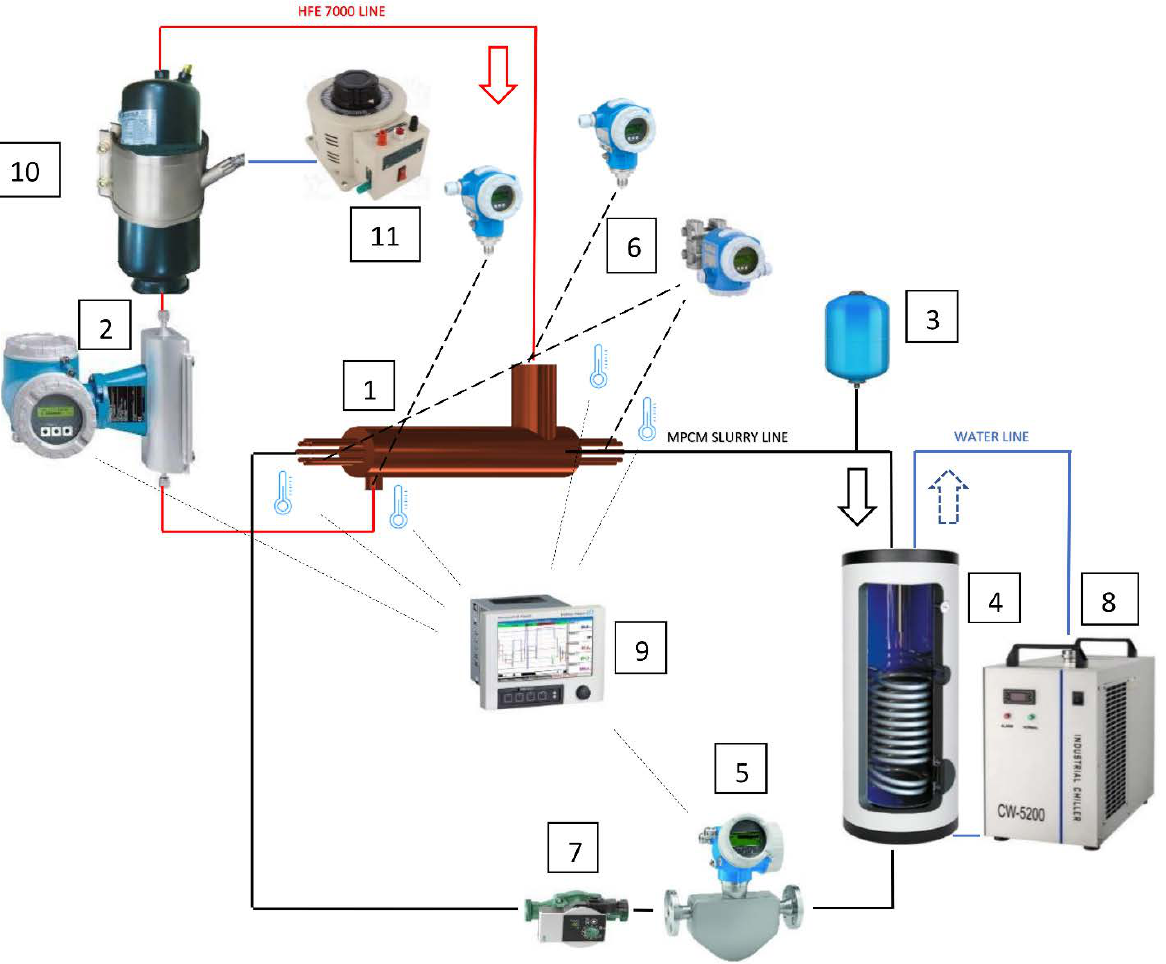
Figure 2. Schematic diagram of the experimental facility: 1—shell and tube heat exchanger; 2—HFE 7000 line Coriolis type mass flow meter; 3—MPCM slurry leveling vessel; 4—spiral coil heat ex- changer; 5—MPCM slurry line Coriolis type mass flow meter; 6—pressure sensors; 7—circulation pump; 8—chiller; 9—recording device; 10—HFE 7000 vessel with heater; 11—autotransformer.